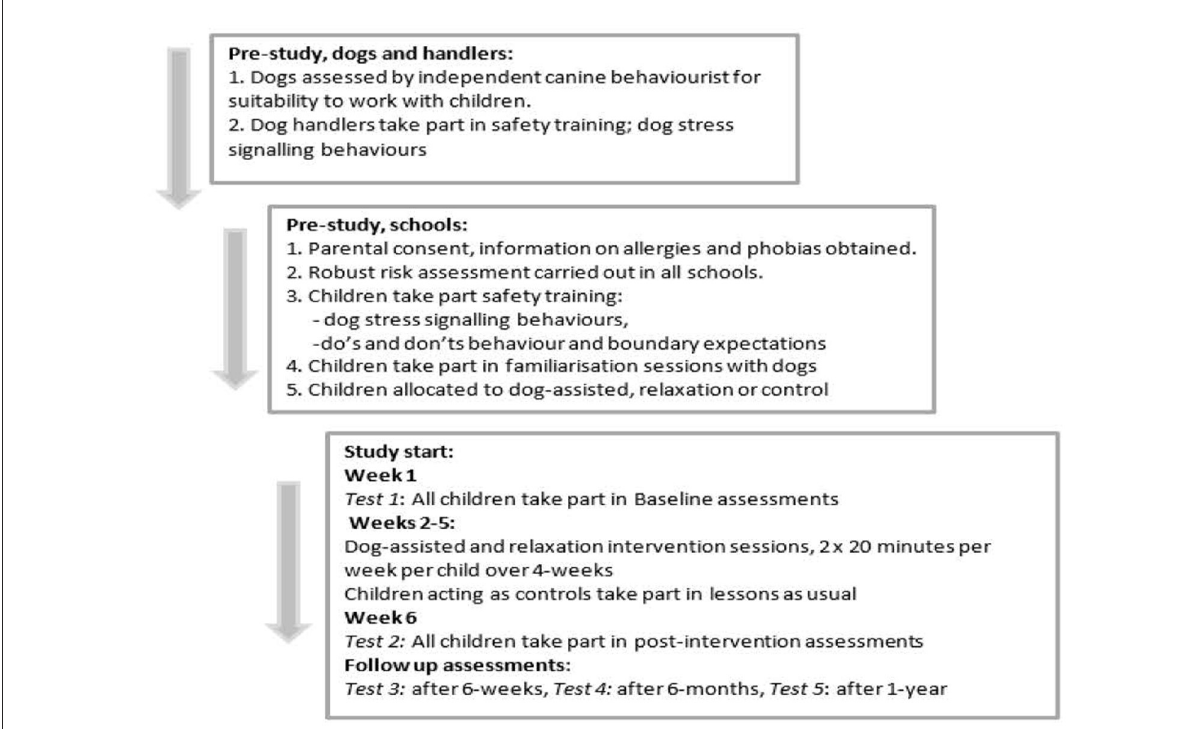
FIGURE1 Welfare, safety, familiarization and consent and assent procedures carried out before and at study start for dogs and handlers, children, parents and schools taking part in the longitudinal randomized controlled trial.